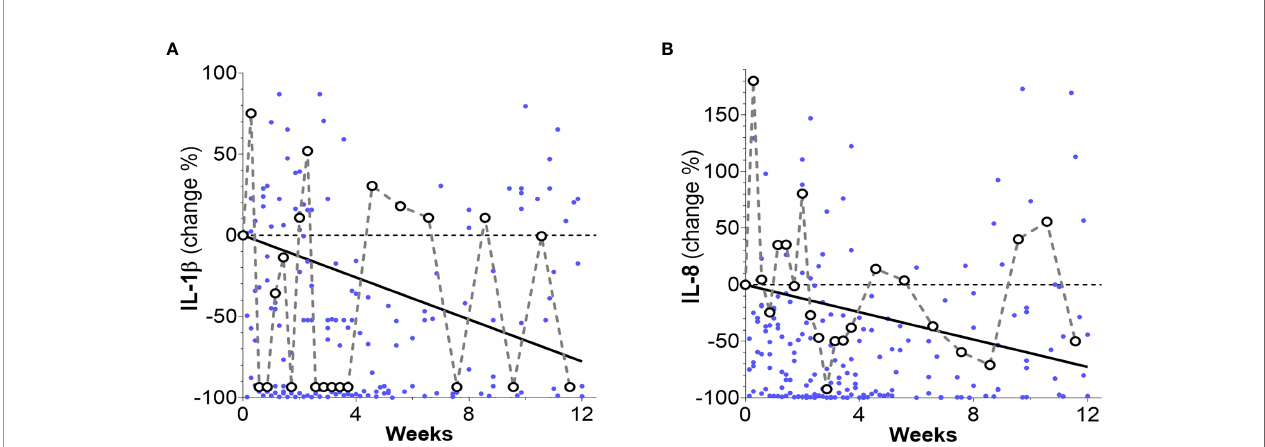
FIGURE 3 | Percentage changes of patients ’ in fl ammation markers levels (dots) and their overall time trends as obtained from linear mixed-effects models. (A) An overall decreasing trend for IL-1 b is observed (solid line) over the whole 12-week time period (slope: -0.19 ± 0.09 pg/mL week, p = 0.042 and intercept 2.95 ± 0.49 pg/mL, p < 0.001). (B) An overall decreasing trend (solid line) was observed for IL-8 (slope: -11.48 ± 5.86 pg/mL week, p = 0.049 and intercept 189.76 ± 32.20 pg/ mL, p < 0.001). Notice that for clarity, 16 data points surpassing the 100% level in (A) and 5 data points surpassing the 200% level in (B) are not shown.